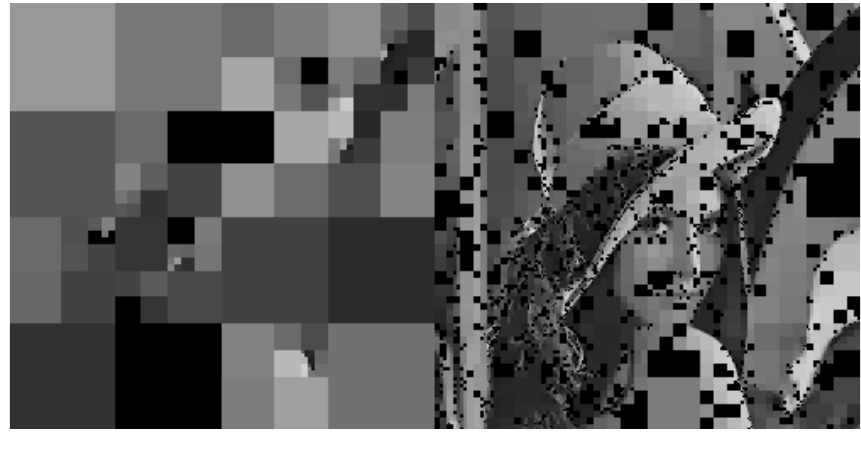
Figure 23 . Initial Transmitted Image Frame ( t = 0 s—left side)—Converged Transmitted Image Frame ( t = 227 s—right side) under 20% Network